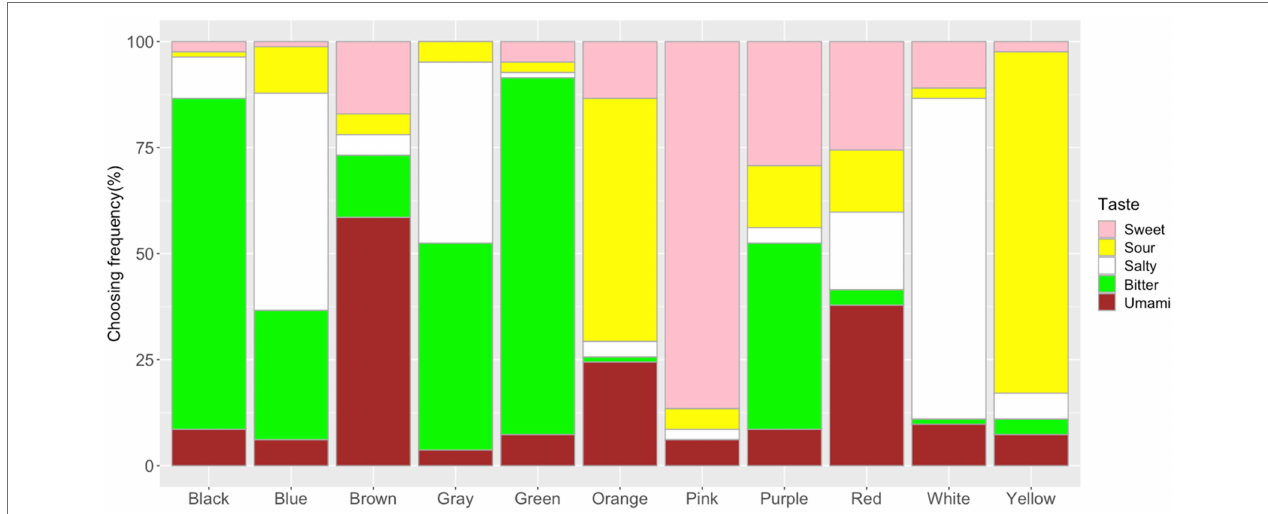
FIGURE 3 | Frequency of taste choices for each color. Note that the frequency of the sweet, sour, salty, bitter, and umami taste terms for the color stimuli are represented by the fill-in colors pink, yellow, white, green, and brown,